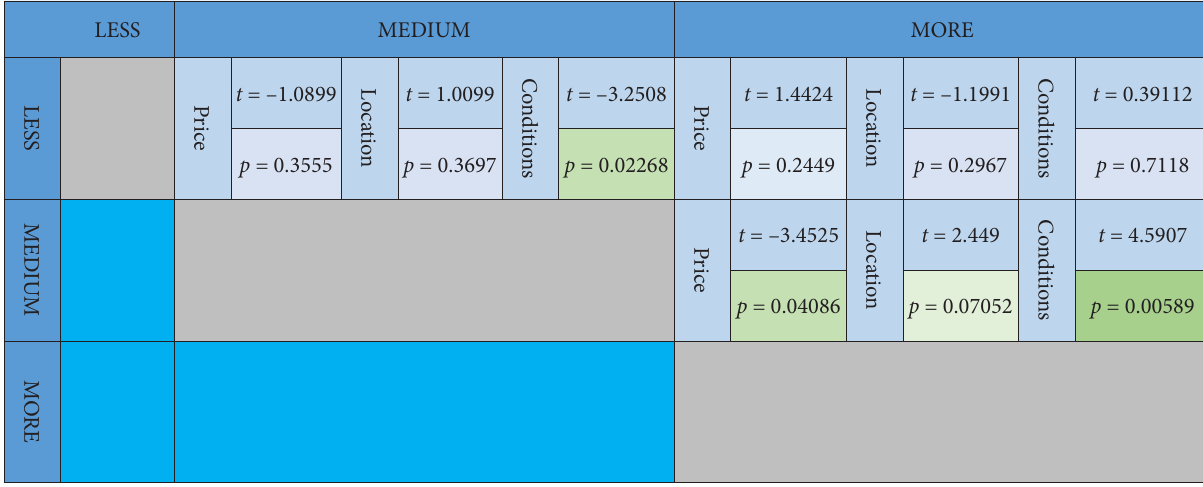
Table 9. Opinions of groups with different levels of co-residence under each construct LESS MEDIUM